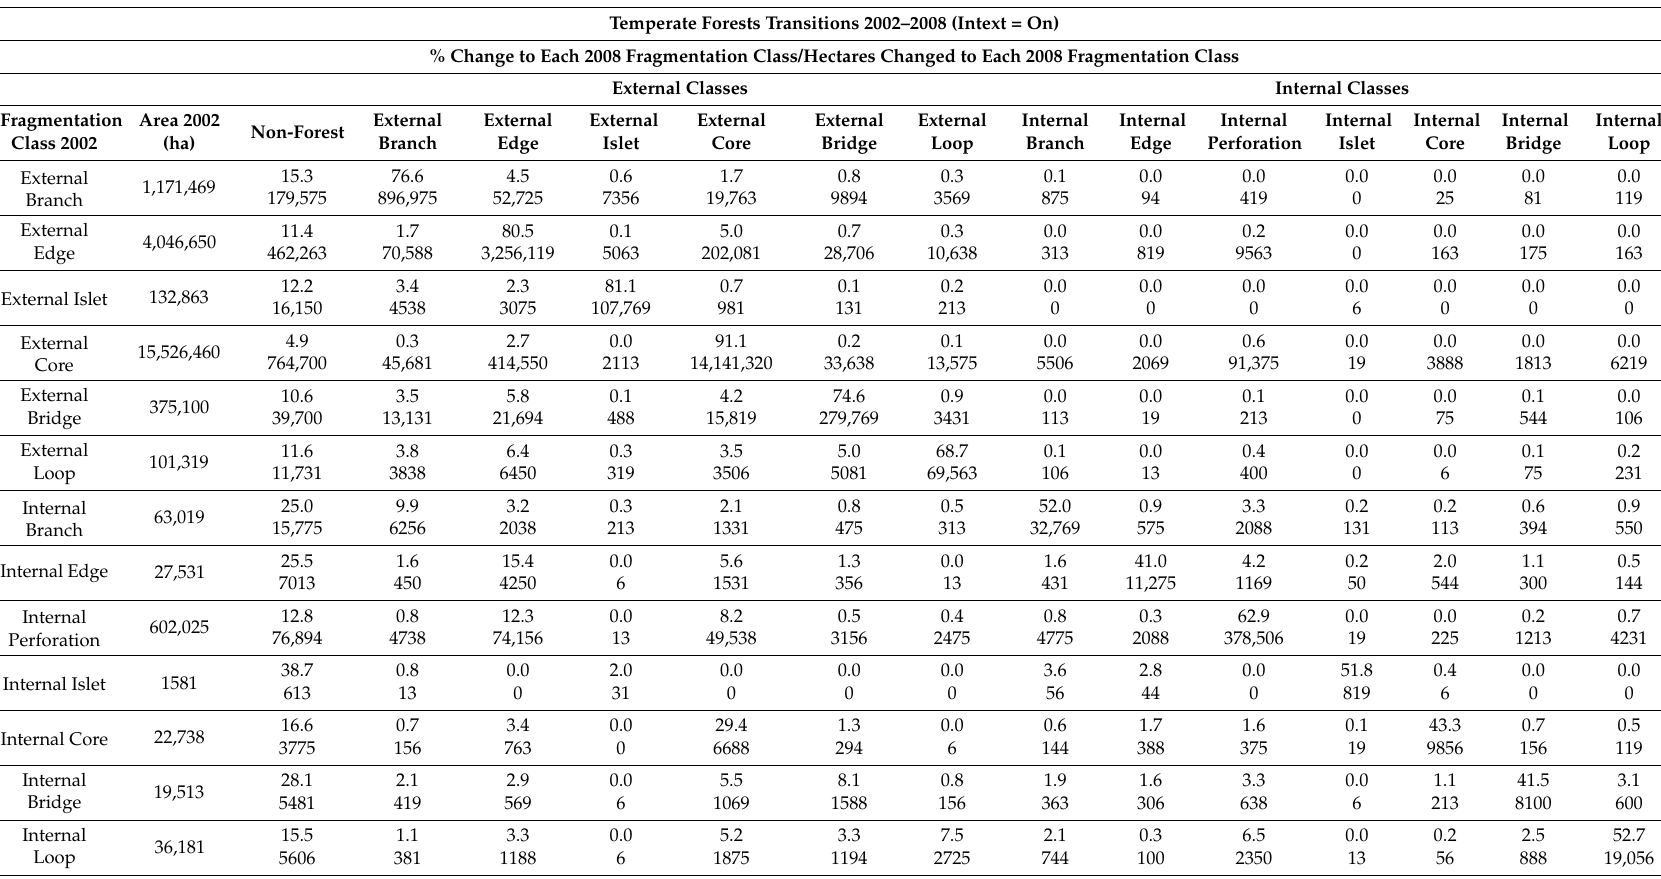
Table D2. Fragmentation classes transition matrix temperate forests in the 2002–2008 period differentiating between internal and external fragmentation classes. Temperate Forests Transitions 2002–2008 (Intext =